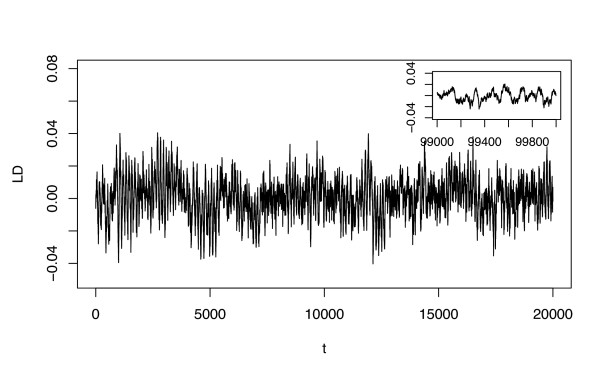
Typical simulation run in the stochastic version (N = 10 000) of the sequential-updating model. The variable t represents host generations. The main figure shows the LD oscillations from the start, the inset shows the dynamics of the LD oscillations later during the simulation (t = 100 000). The following parameters were used: rmm = 0.1, sH = sP = 0.05.